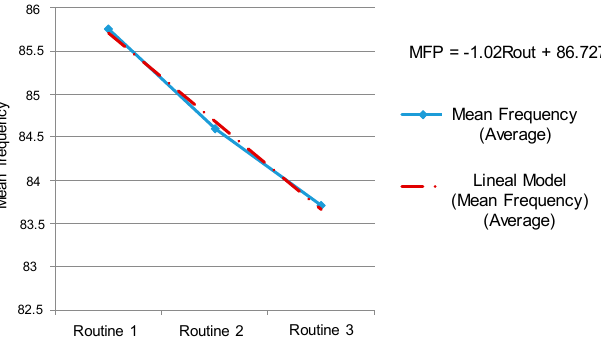
11 of 14 Figure 9. Results obtained with linear regression in the amplitude analysis for routine 2 in the vast external: ( a ) Player 2; ( b ) Player 6. 3.3. Results Obtained between Routines This section shows an analysis of the general progress of the athlete between routines, as a new alternative method to estimate fatigue indexes. This consists in finding a representative value of each